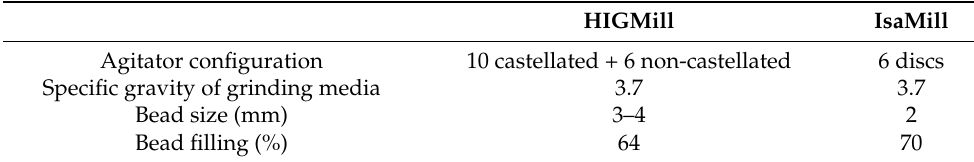
Table 2. The milling environment of HIGMill and IsaMill.